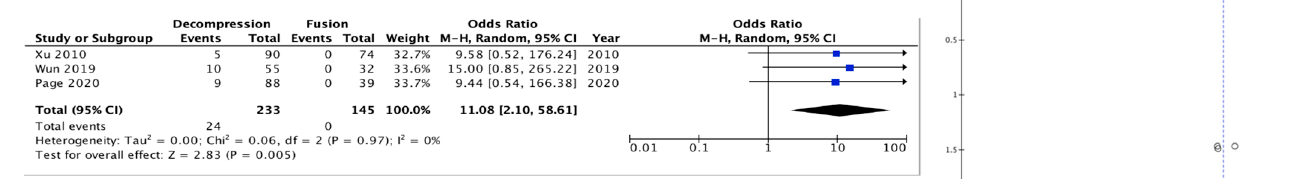
10 of 13 Figure A4. Motor de fi cit. Figure A5. Sensory de fi cit. Figure A6. Bowel/bladder de fi cits.